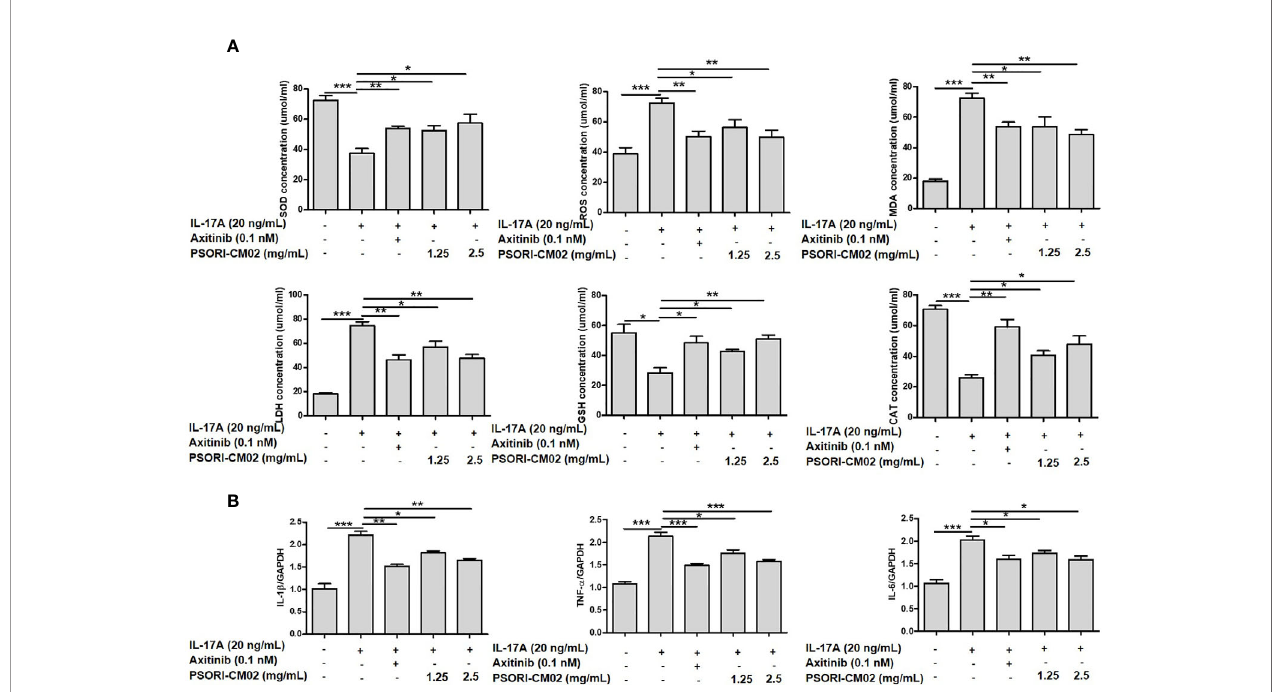
FIGURE 2 | Effects of PSORI-CM02 on oxidative stress and in fl ammation in interleukin (IL)-17A-stimulated human umbilical vein endothelial cells (HUVECs). (A) HUVECs were treated with 1.25 or 2.5 mg/mL PSORI-CM02 for 24 h and then stimulated with 20 ng/mL IL-17A for 6 h. Subsequently, the cells were collected and tested using superoxide dismutase (SOD), reactive oxygen species (ROS), malondialdehyde (MDA), lactate dehydrogenase (LDH), glutathione (GSH), and catalase (CAT) assay kits, according to the manufacturers ’ instructions, to detect the effects of PSORI-CM02 on antioxidative/oxidative factors. (B) Total RNA was isolated from HUVECs, and RT-PCR was used to investigate the levels of various pro-in fl ammatory cytokines. Data represent the mean ± SEM of at least three independent experiments (* p < 0.05, ** p < 0.01, *** p < 0.001 vs. the IL-17A-stimulated HUVEC